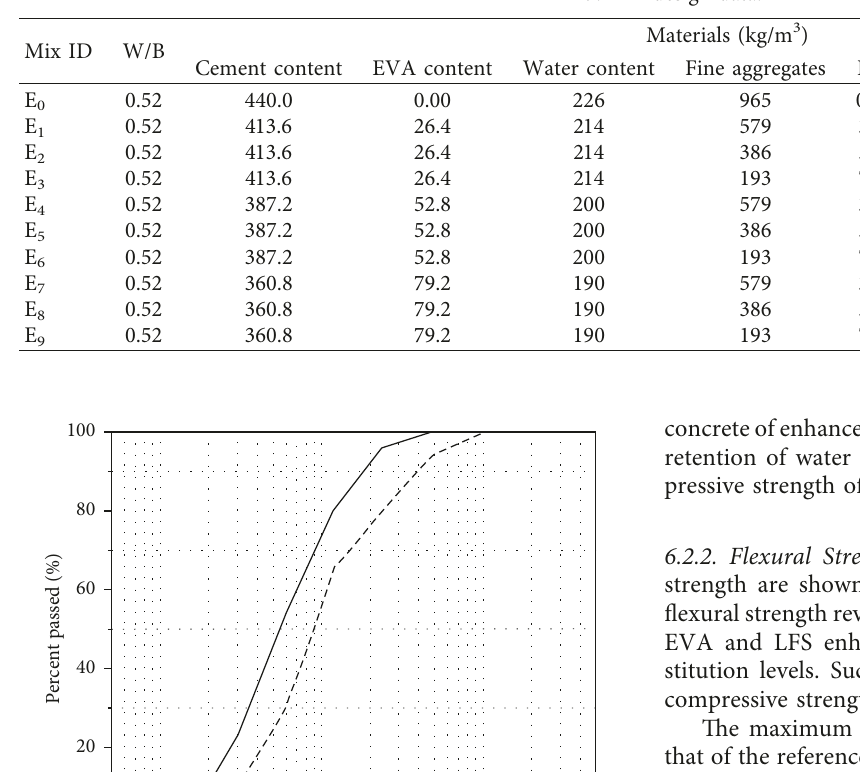
Table 7: Mix design data.